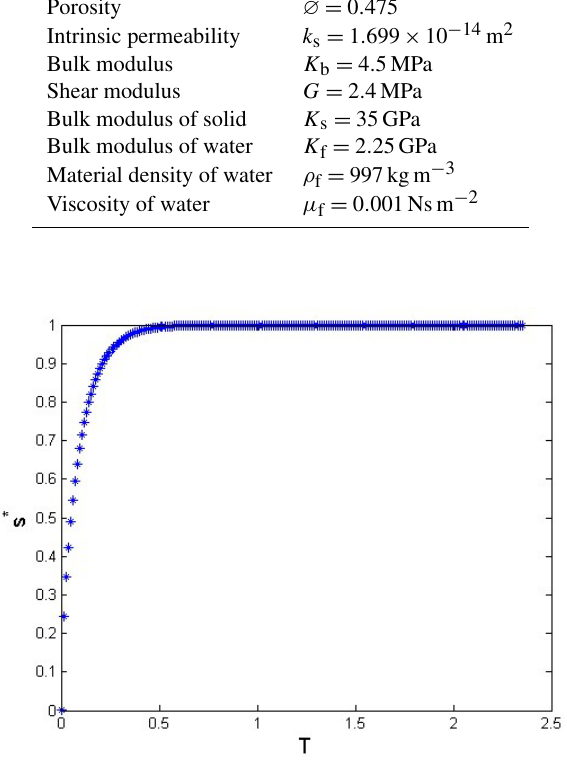
Figure 4. The dimensionless surface settlement versus time.